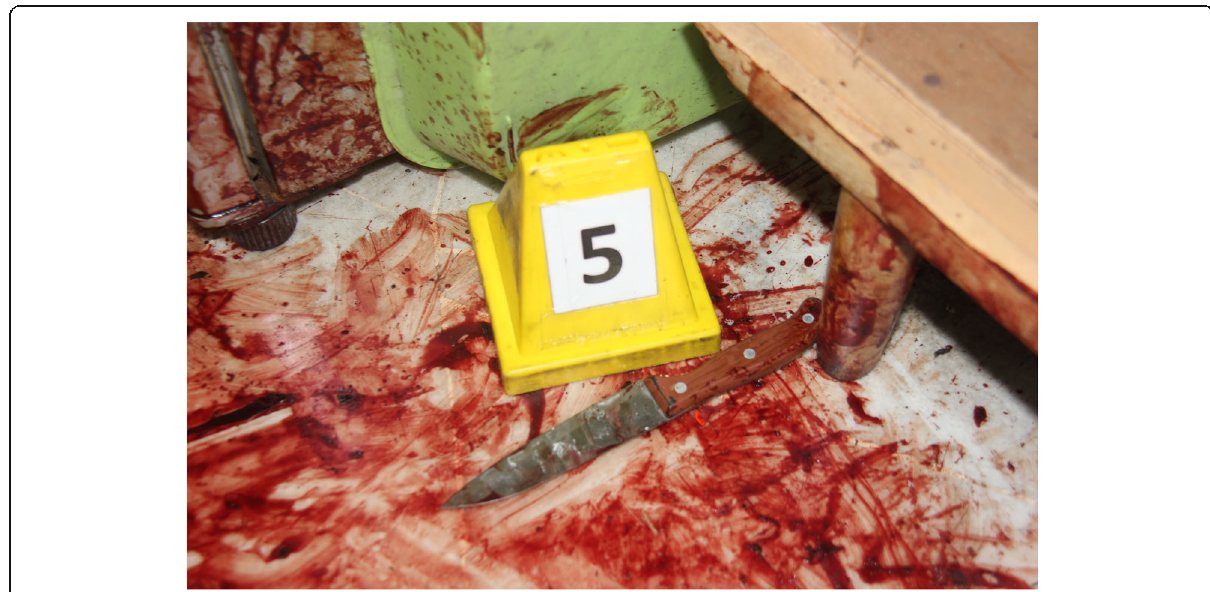
Fig. 3 A blood-stained kitchen knife was found next to the